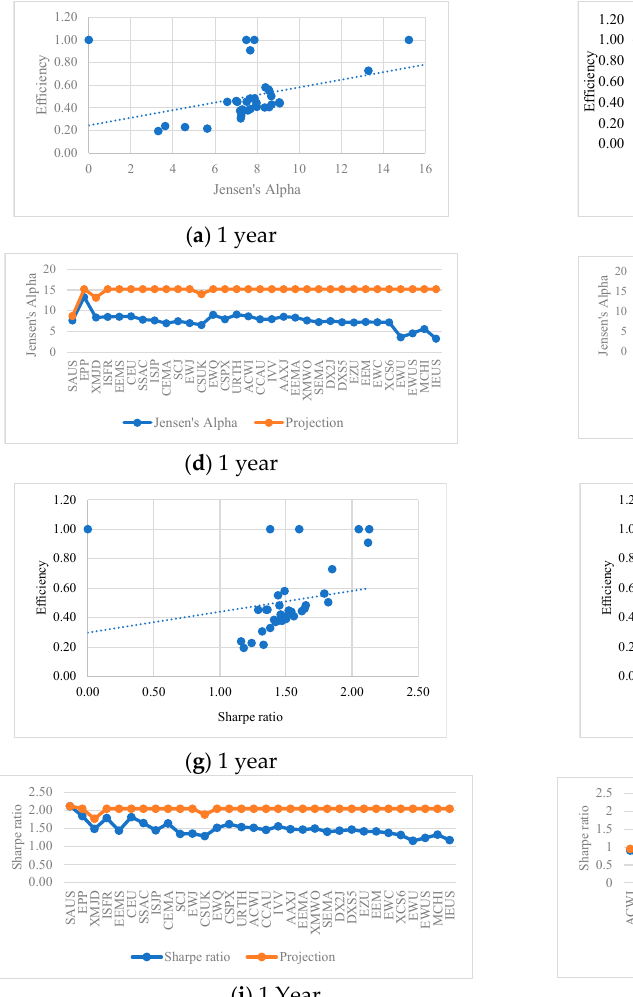
Figure 1. Efficiency scores vs. inputs and projections (ETFs are ordered in decreasing order of efficiency) for the different time horizons–M1.